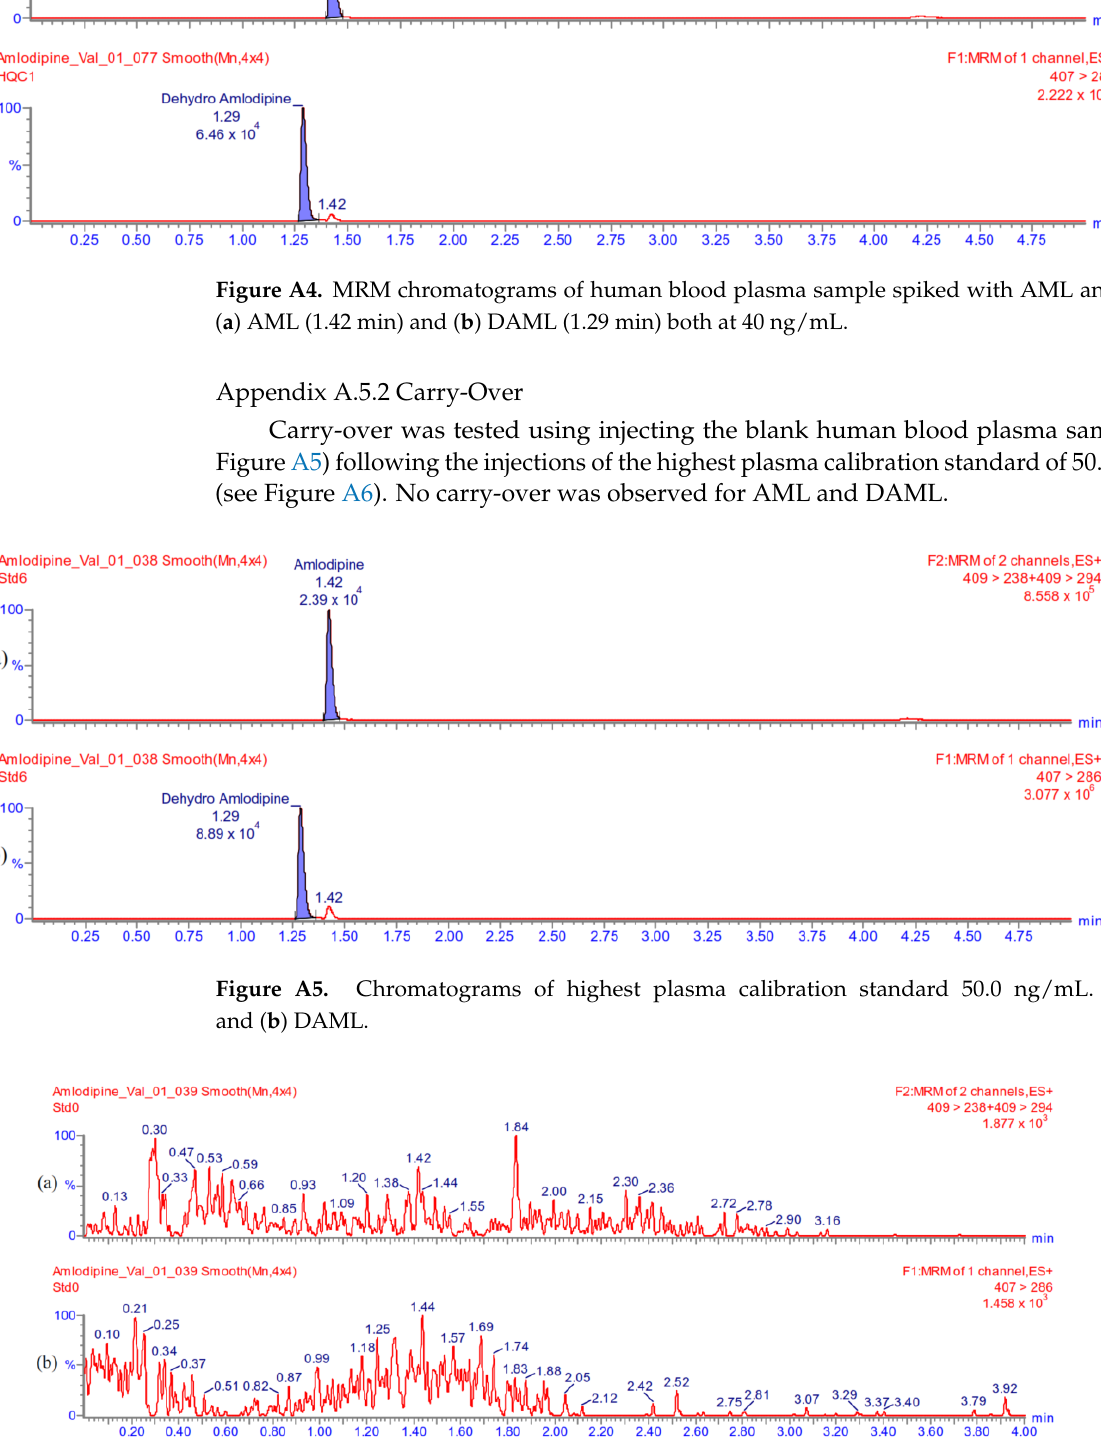
Figure A3. MRM chromatograms of human blood plasma samples spiked with AML at 40.0 ng/mL. ( a ) AML MRM chromatogram. ( b ) DAML MRM chromatogram (bottom plot).